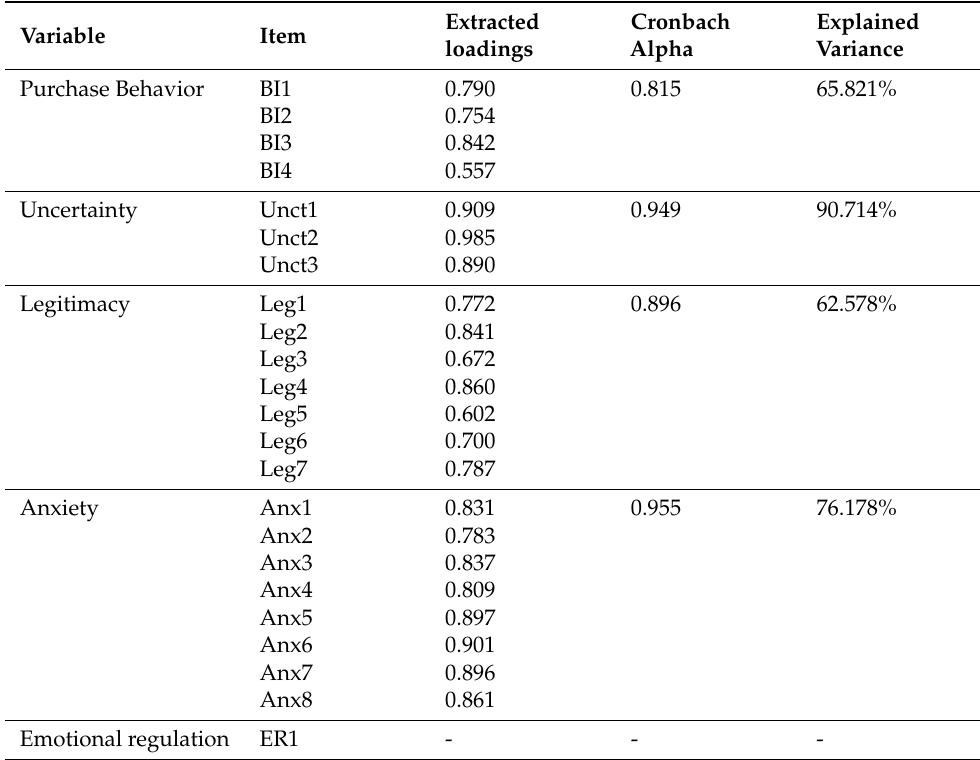
Table 2. Results from the factorial